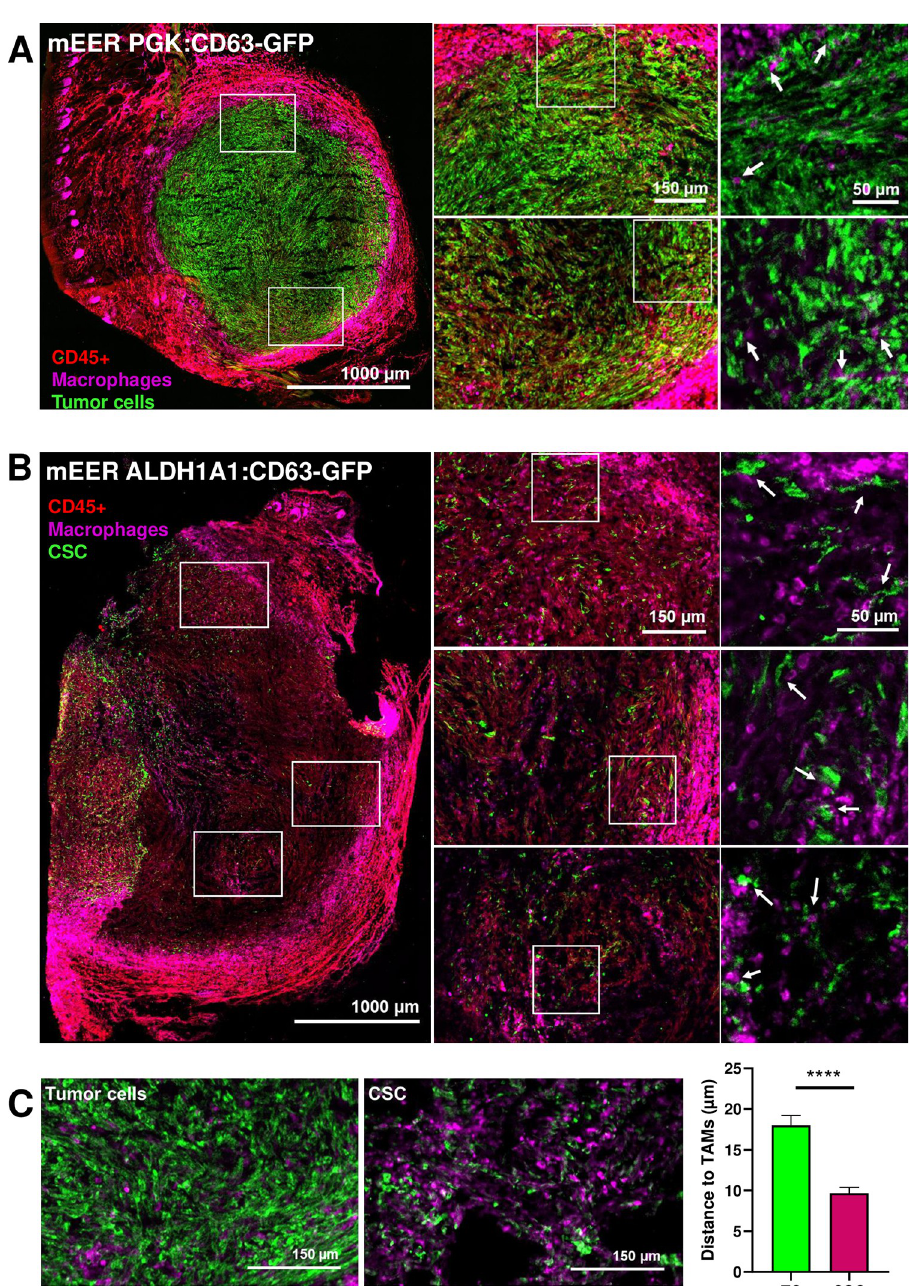
Fig 3. CSC show close localization to TAMs in the TME. (A) Representative IF images of tumor sections carrying mEER PGK : CD63-eGFP tumor cells. eGFP+ cells represent the total tumor cell population. Arrows in the insets indicate TAMs-tumor cells interactions. (B) Representative IF images of tumor sections presenting mEER ALDH1A1 : CD63-eGFP tumor cells. eGFP+ cells represent the CSC population. Arrows in the insets indicate TAMs-CSC interactions. (C) Examples of analyzed tumor areas employed to measure the distance in μ m observed between tumor eGFP+ cells, eGFP+ CSC and TAMs using ImageJ software. Mann-Whitney test was used for statistical analysis.